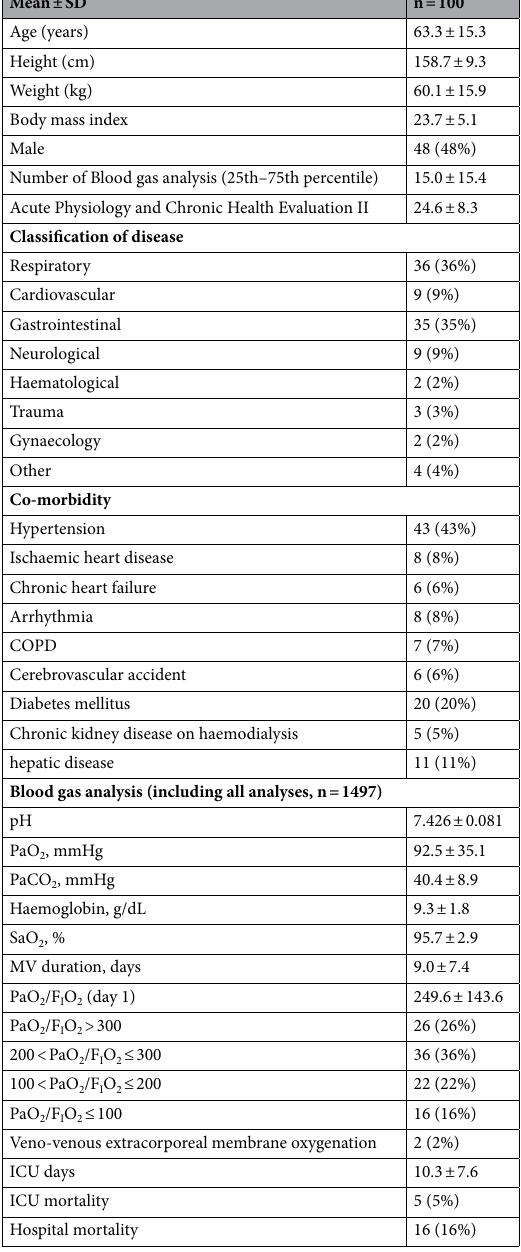
Table 1. Patient characteristics. COPD chronic obstructive pulmonary disease, ICU intensive care unit, SaO 2 arterial oxygen saturation, SpO 2 pulse-oximetric oxygen saturation, PaCO 2 arterial carbon dioxide tension, PaO 2 arterial oxygen